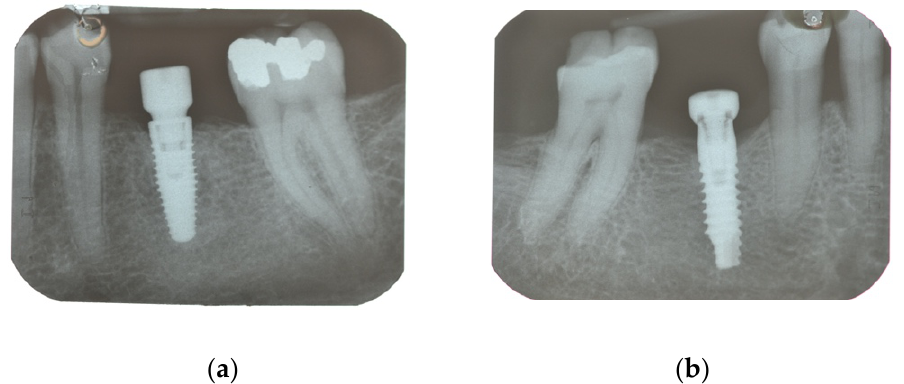
Figure 1. Radiographs of the implants with the screw healing at the time of insertion ( a ) Nobel Parallel; ( b ) Prama Sweden & Martina. Radiograph when the screw-retained restoration was delivered. Figures should be placed in the main text near to the first time they are cited. A caption on a single line should be centered.